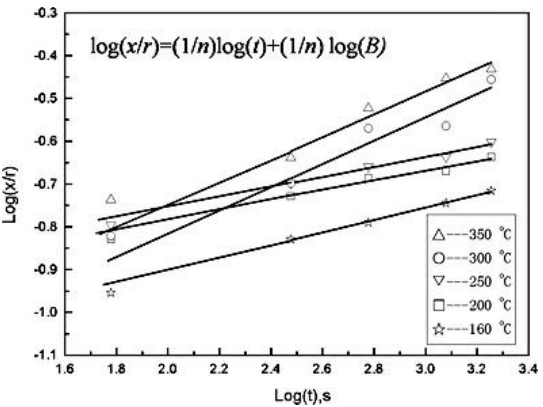
Figure 2. Neck growth kinetics during the sintering process of nanosilver particles at different temperatures. Reproduced with permission from [51].